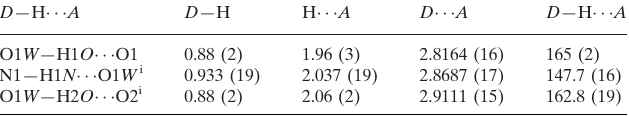
Key indicators: single-crystal X-ray study; T = 150 K; mean (cid:2) (C–C) = 0.002 A˚; R factor = 0.030; wR factor = 0.070; data-to-parameter ratio = 16.2. rac -Benzyl 3-oxohexahydro-1 H -pyrrolo[3,4- c ]pyridine-5(6 H )-